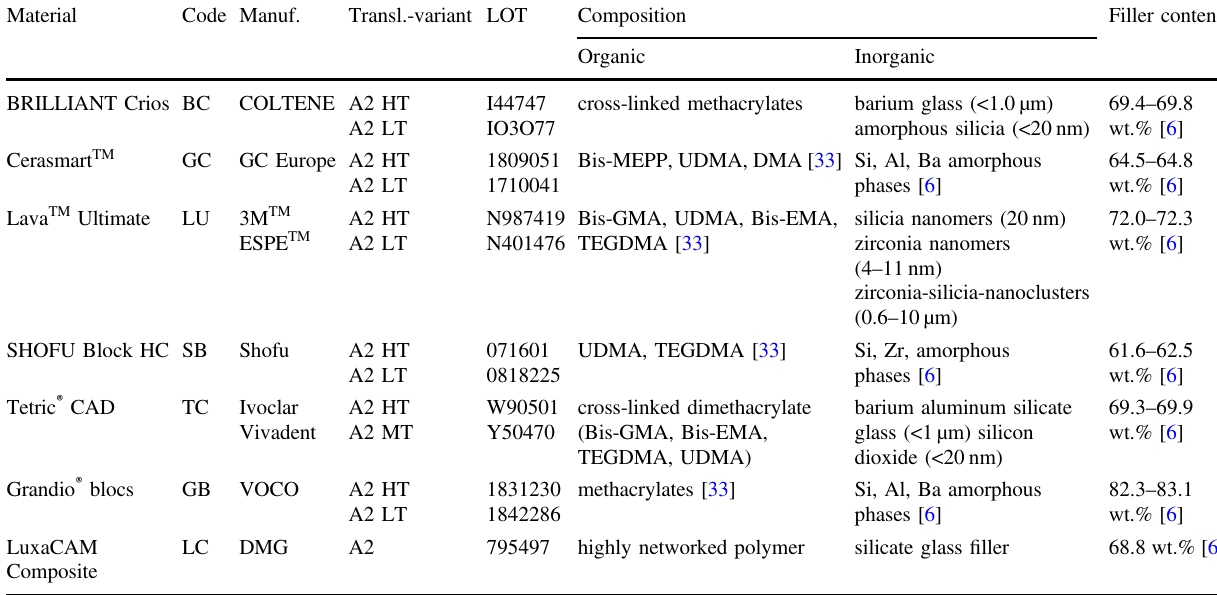
Table 1 Product information of the materials used; the information provided by the manufacturers has been reported unless indicated otherwise Material Code